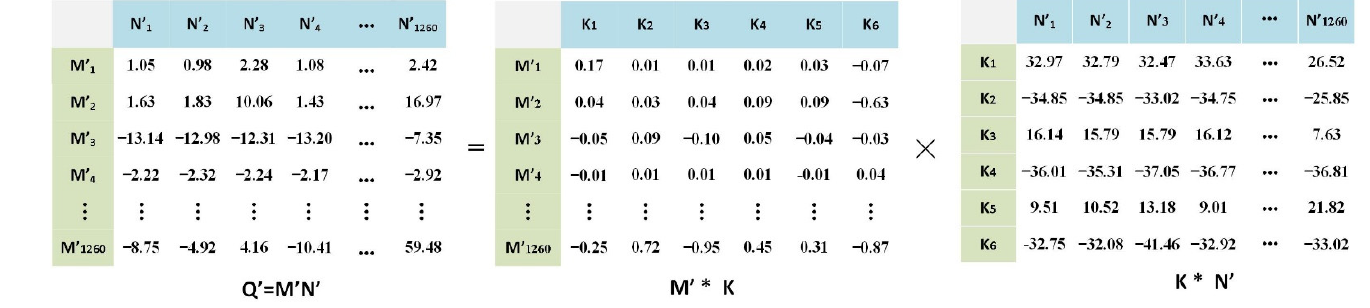
Figure 5. Results of the data fusion.